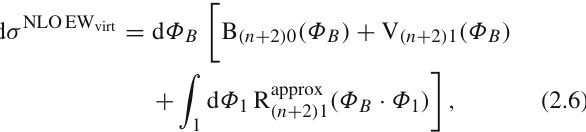
Fig. 2 Leadingjettransversemomentumin t ¯ t + jetproductionatNLO EW at 13TeV at the LHC. The top panel shows the differential cross section, while the lower panel shows the subleading Born and one-loop electroweak corrections. Colour and line coding as in Fig.